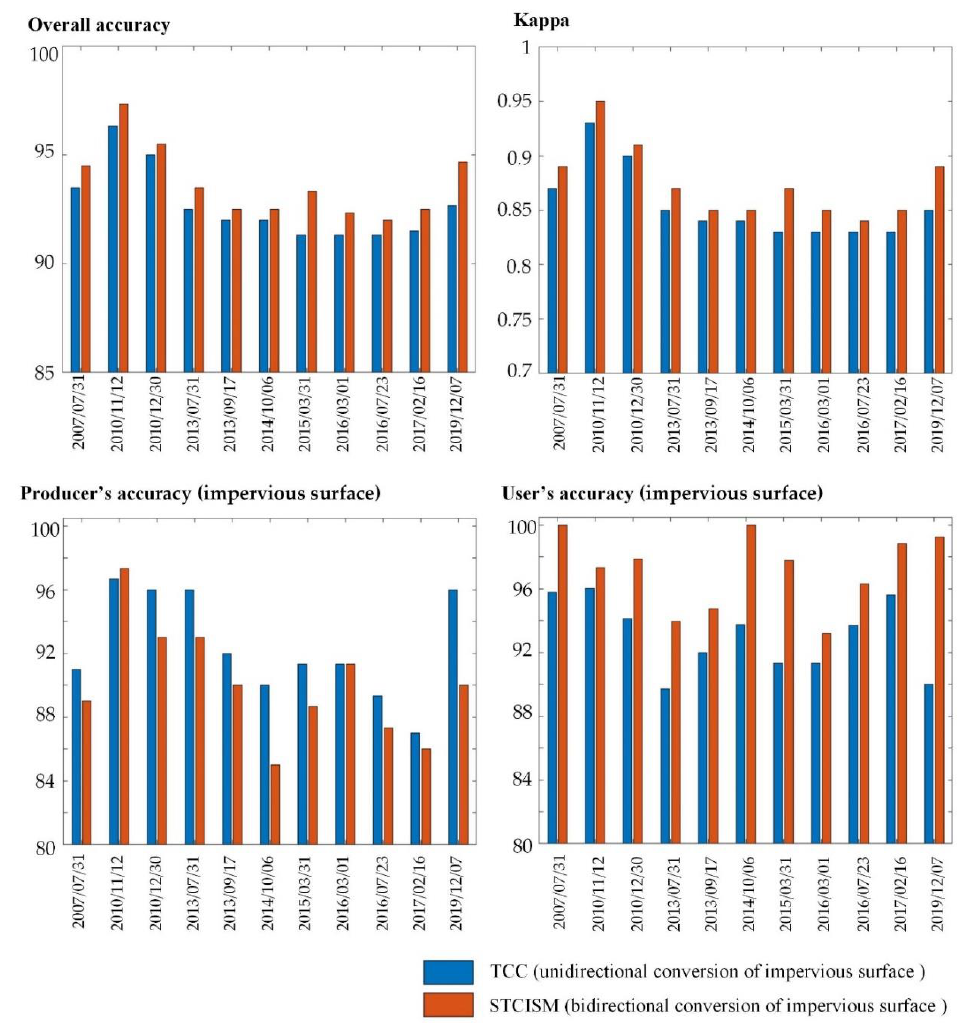
Figure 10. Accuracy of the traditional TCC model that only considers the unidirectional pervious-to-impervious conversion with the proposed STCISM that considered the bidirectional conversion.